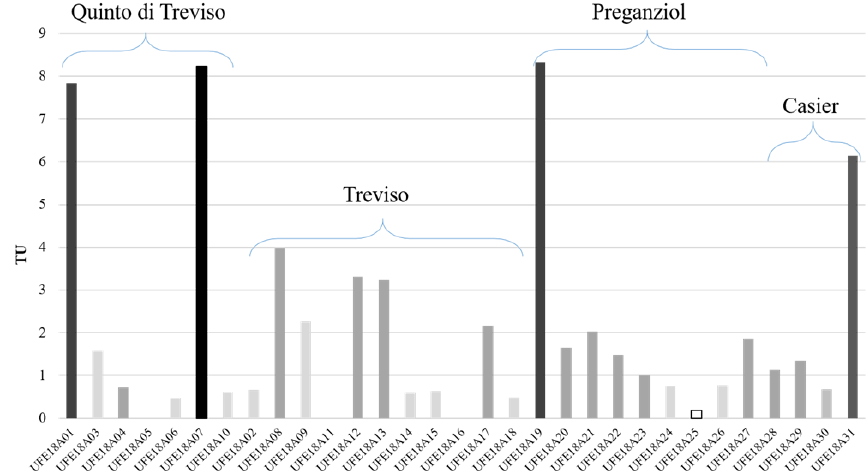
Figure 2. Graph showing the different concentrations of tritium (expressed in TU = tritium unit) in the samples collected from the selected wells, separated on the basis of the sampling area: Quinto di Treviso, Treviso, Preganziol and Casier.